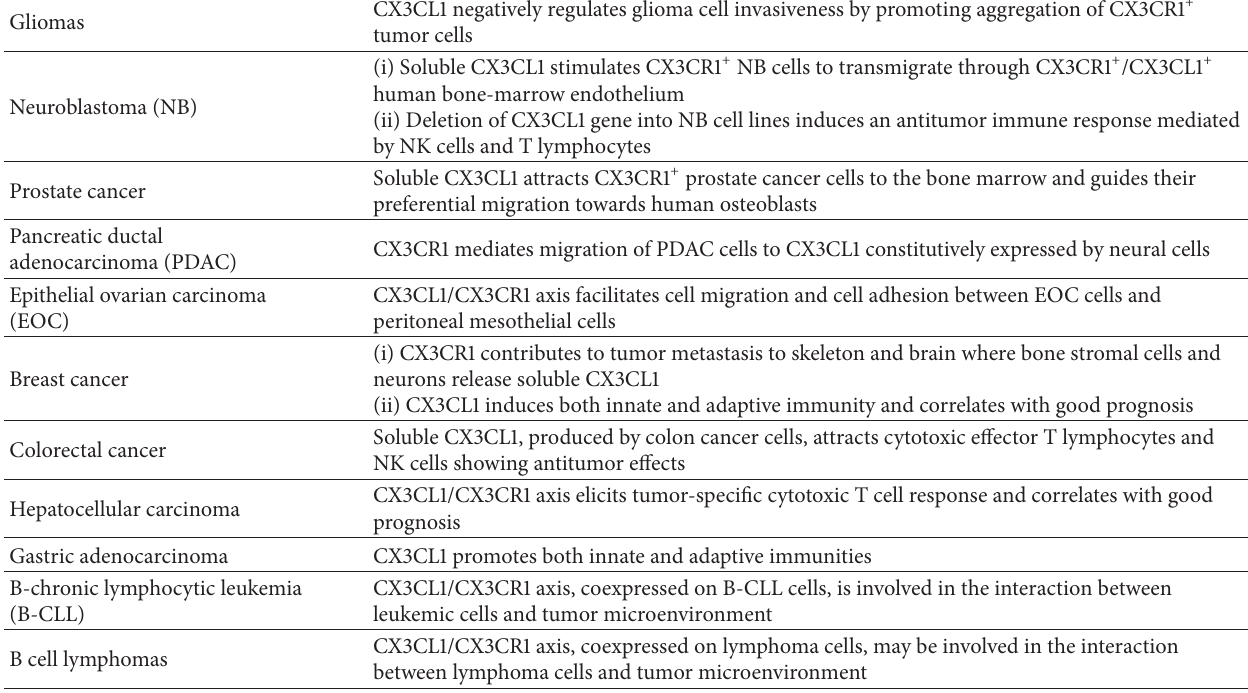
Table 3: Role of CX3CL1/CX3CR1 axis in